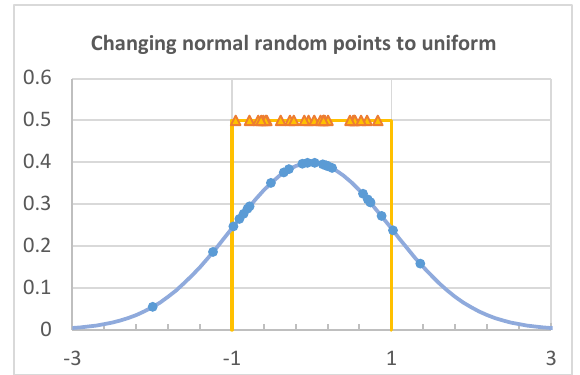
Fig 1 : Constraints on mubar uncertainty due to the distribution and value of mubar Fig. 2 : Transformation of normal random points to a